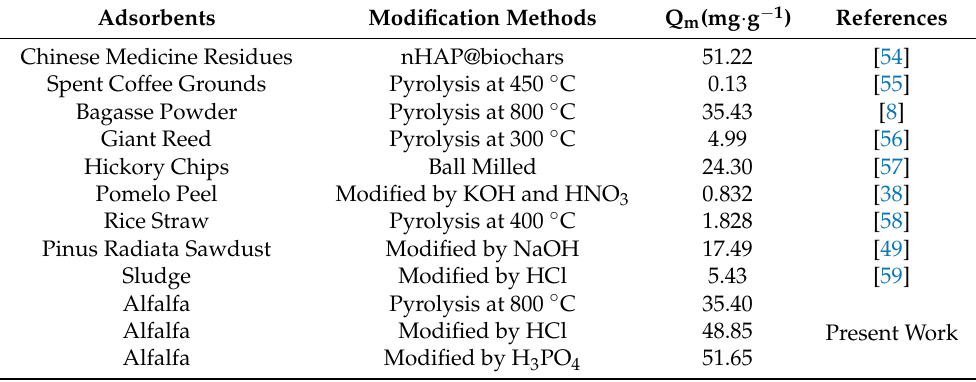
Table 1. Comparison of the maximum adsorption capacities of SMX onto various